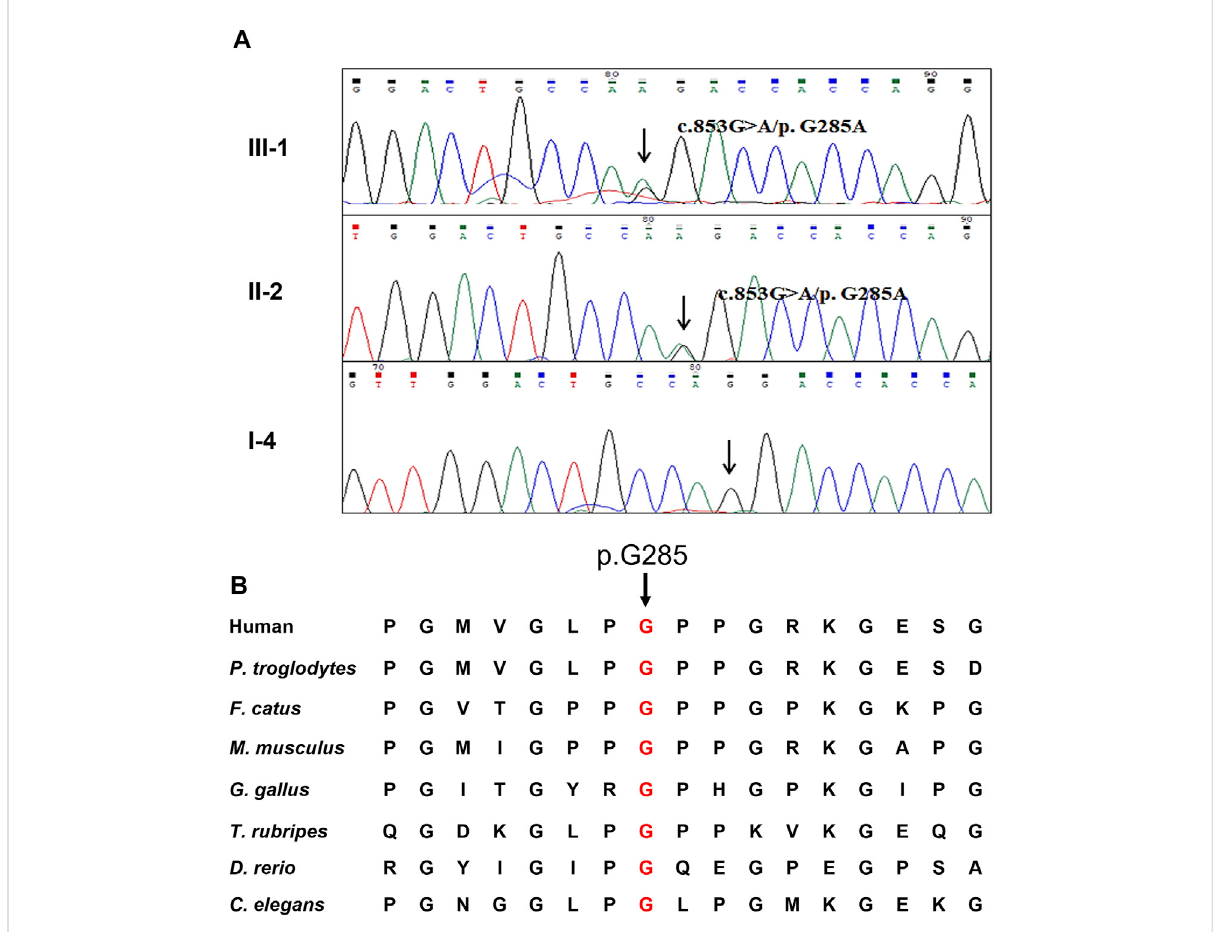
FIGURE 2 Genetic description of the Chinese family (A) Sanger sequencing results of the missense COL4A4 mutation among two affected family members and one healthy member (B) Alignment analysis of this site (p.G285) in COL4A4 amino acid sequences shows that the site (p.285) is highly